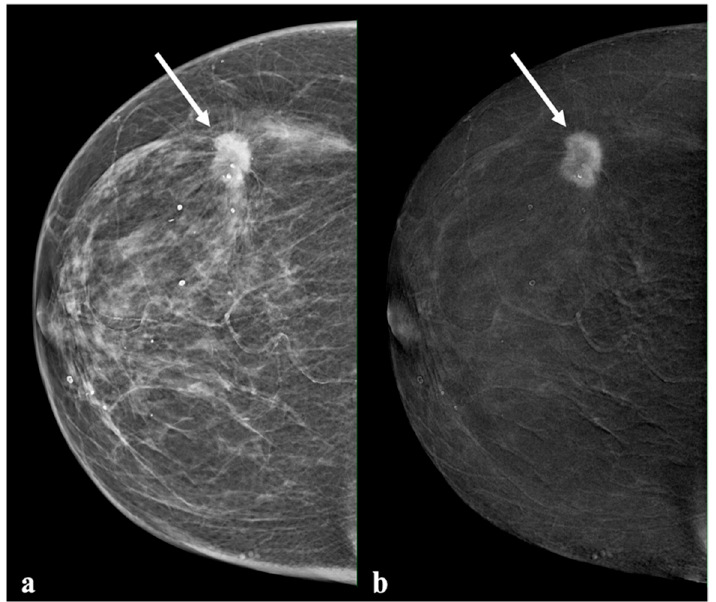
Figure 3. Example of a lesion with marked enhancement (Grade 3). A 71-year-old patient with a spiculated lesion in the outer quadrant of the right breast. Histology showed an invasive cancer. Mammography (( a ), low energy) showed a dense, irregular, and spiculated mass (arrow). ( b ) The recombined image ( b ) showed minimal background parenchymal enhancement and a mass with a marked rim enhancement (arrow).